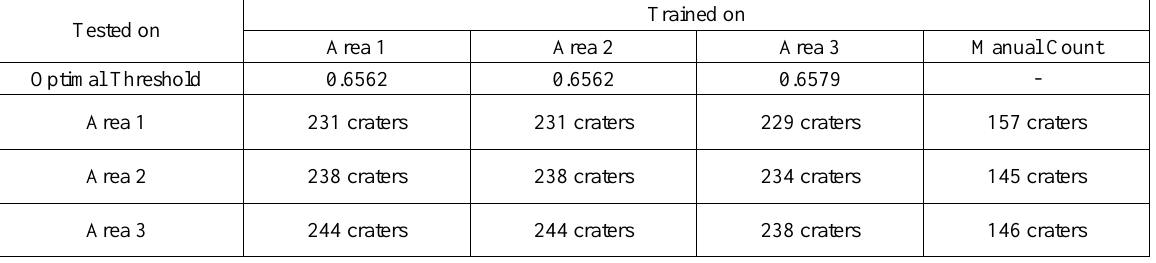
Table 1. Results of the threshold adaptation: number of craters. Tested on